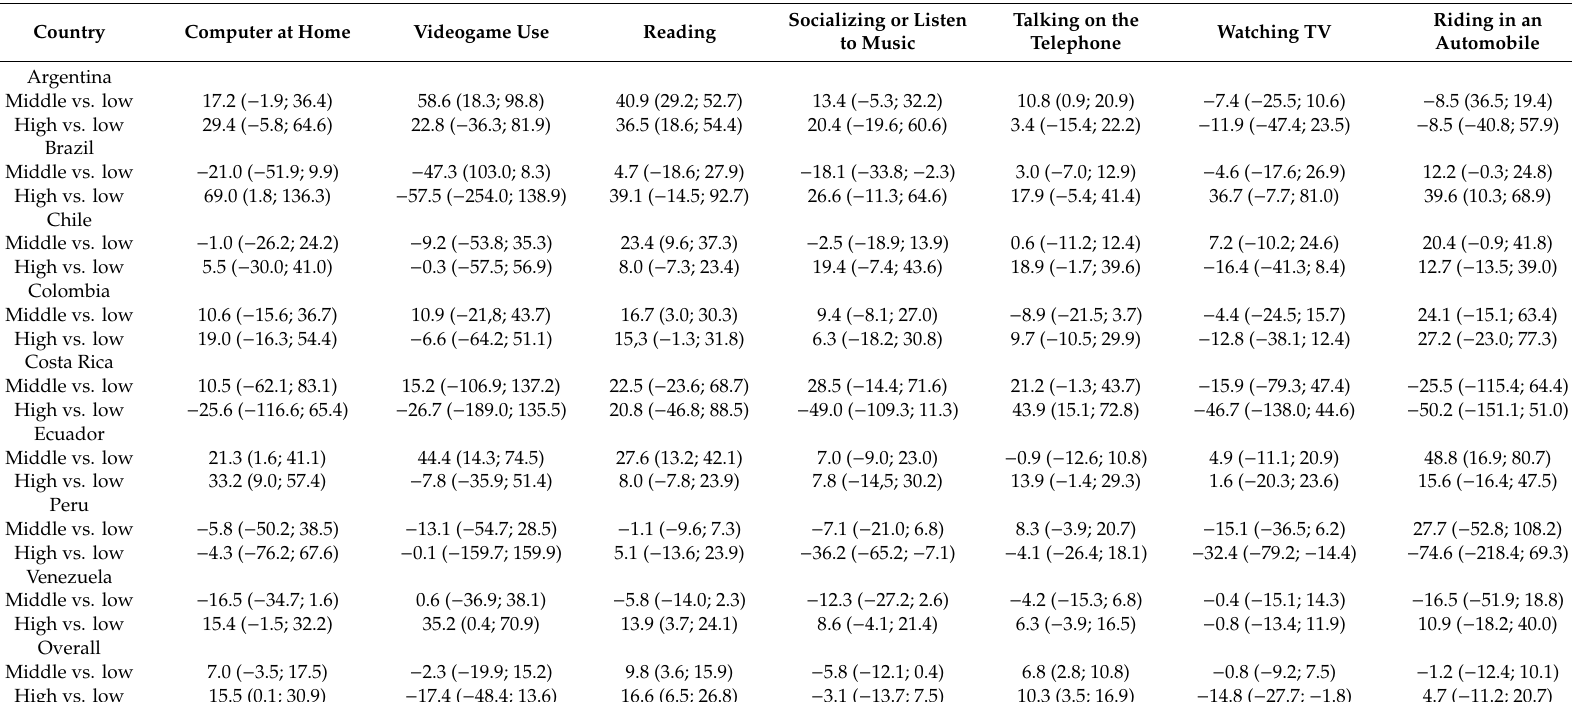
Multilevel linear regression models, including region and cities as random e ff ects, adjusted for sex, age, ethnicity, socioeconomic and education level. Reference: low; CI: confidence